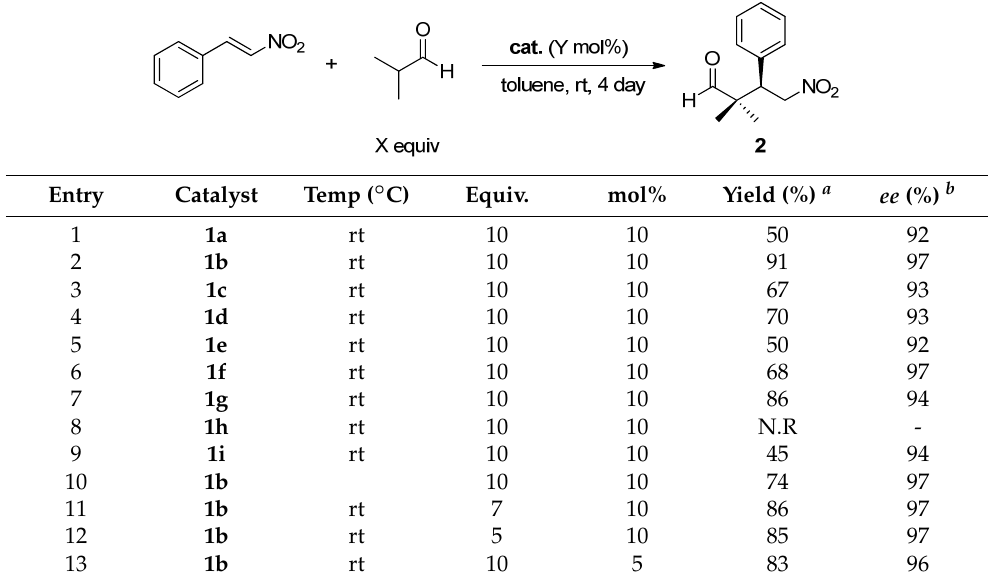
Table 1. Catalyst optimization. Table 1. Catalyst